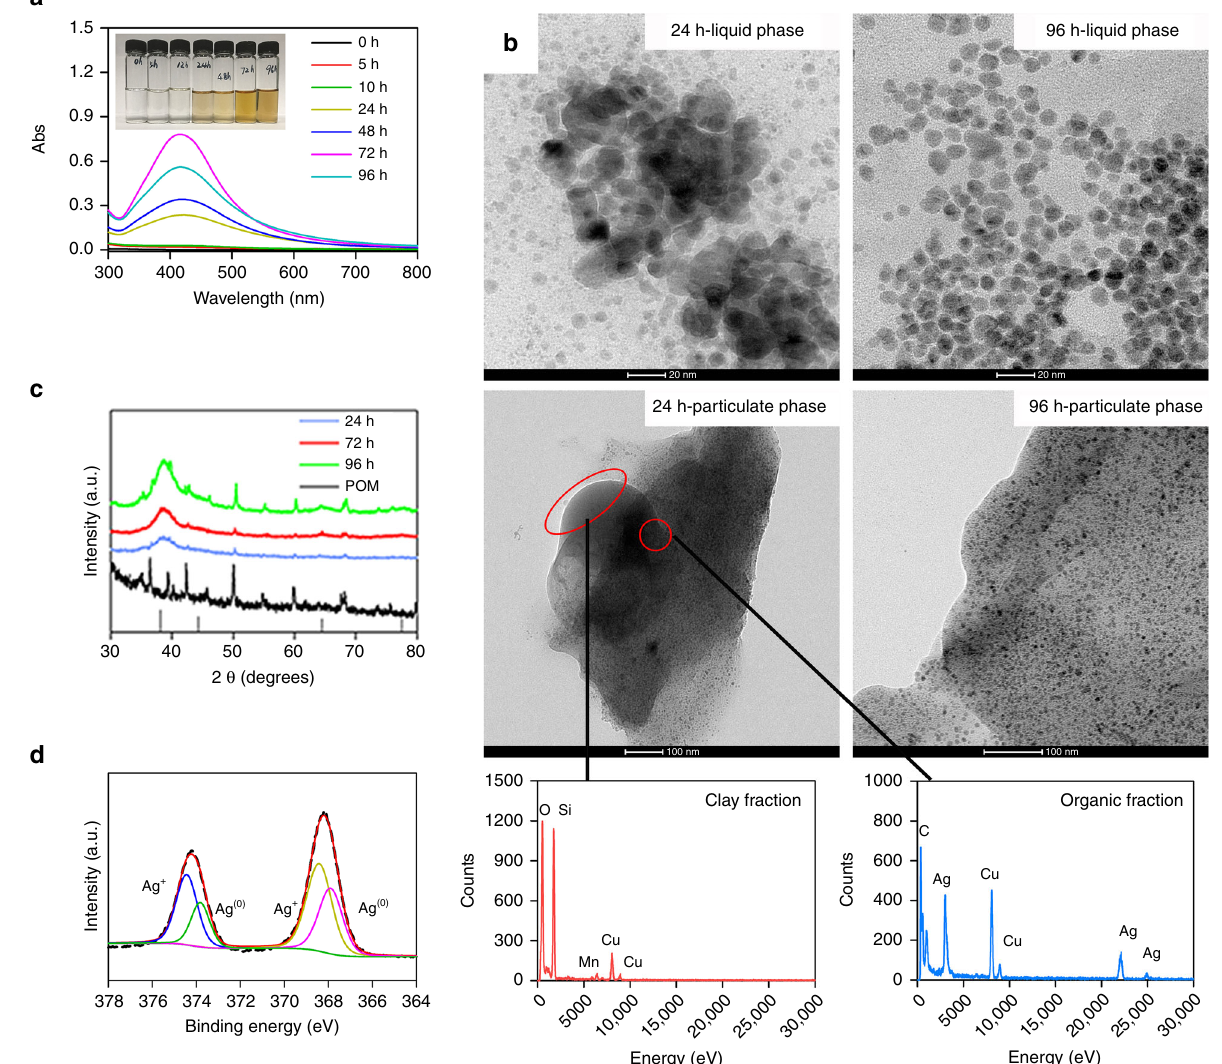
Fig. 2 Silver nanoparticles in simpli fi ed suspension under simulated sunlight. Silver ions (Ag + ) at 0.93 mM were incubated with particular organic matter (POM) at 143.2 mg C L − 1 at pH 8.6. a UV – Vis spectra of AgNPs in liquid phase (insert showing the color evolution of the sample over time). b TEM images of AgNPs in liquid and particulate phase and the respective EDS analysis after 24 h of incubation with POM. c XRD analysis of Ag loaded onto POM. d XPS analysis after the incubation of Ag + with POM for 24